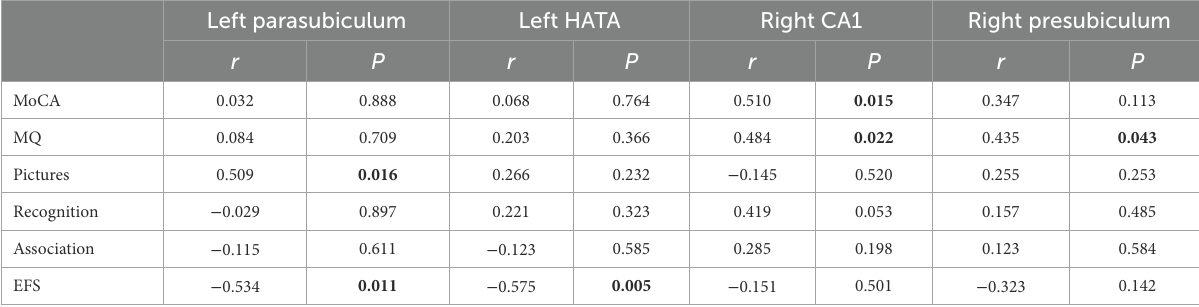
TABLE 5 Correlation between the volume changes of hippocampal subregion and changes of cognitive ability and physical frailty in Baduanjin group ( n =